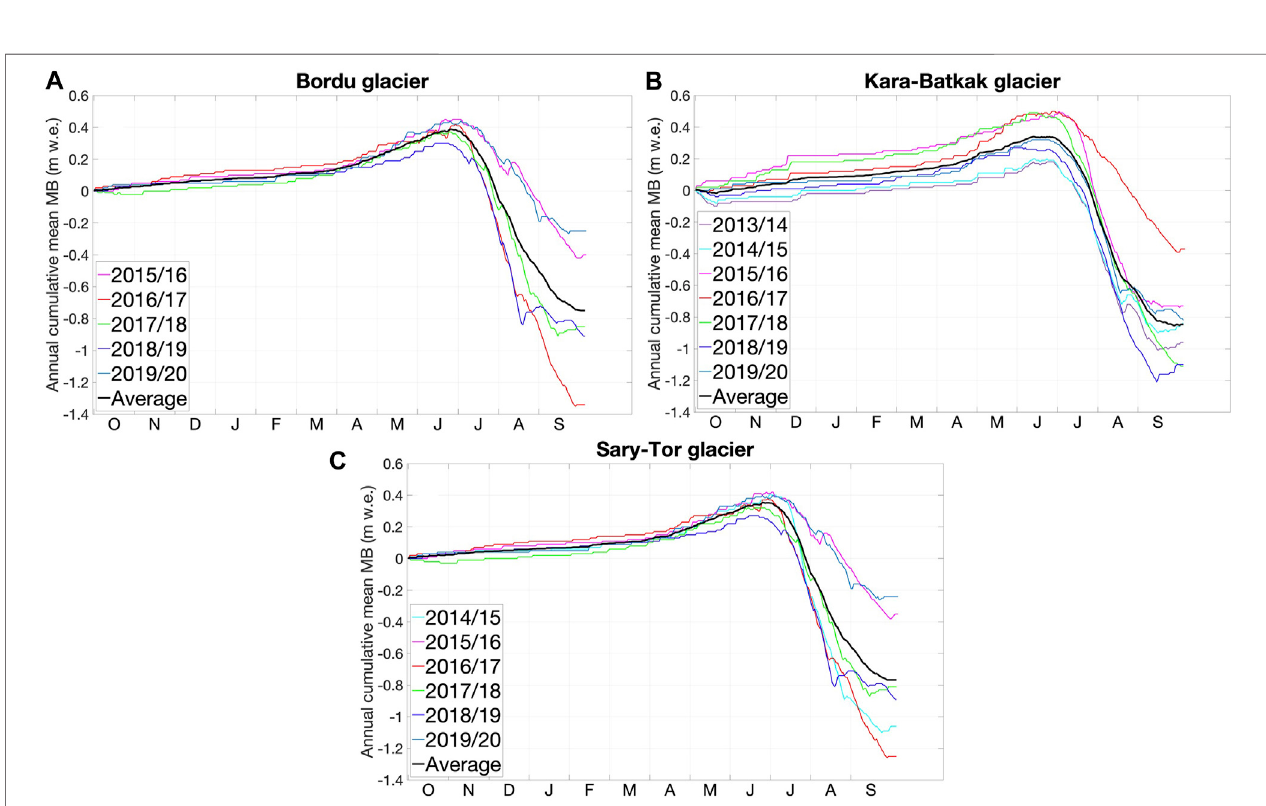
FIGURE 12 | Yearly evolution of the cumulative mean mass balance (MB) at daily resolution.